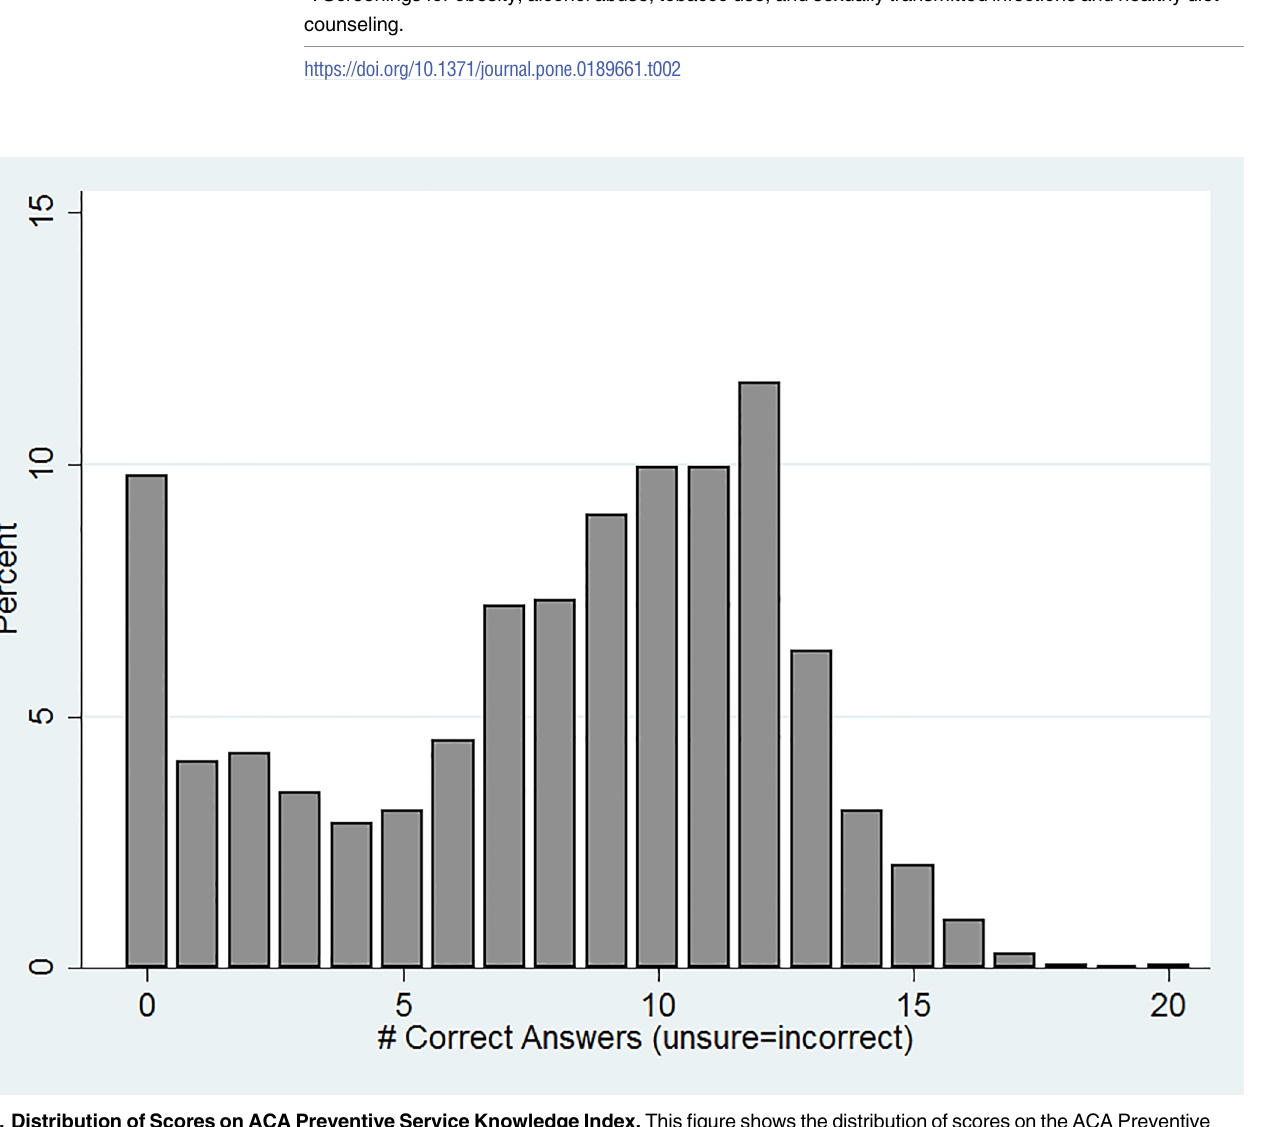
PLOS ONE | https://doi.org/10.1371/journal.pone.0189661 December20,